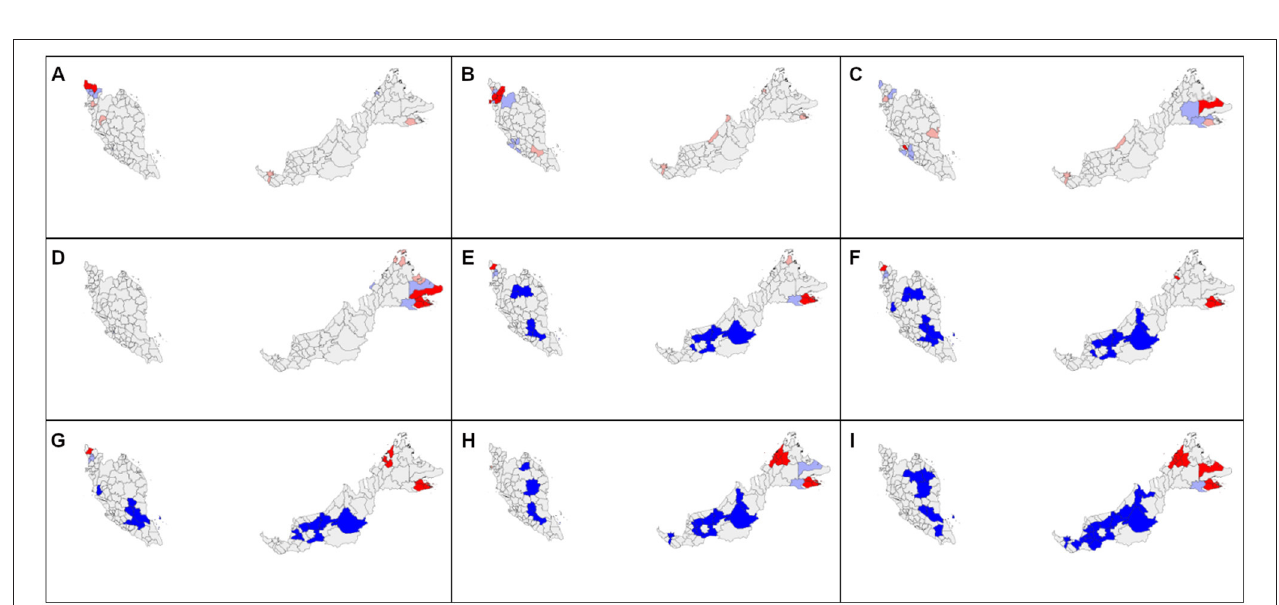
FIGURE 4 | Total COVID-19 new cases by state from August 1 to October 31, 2020.